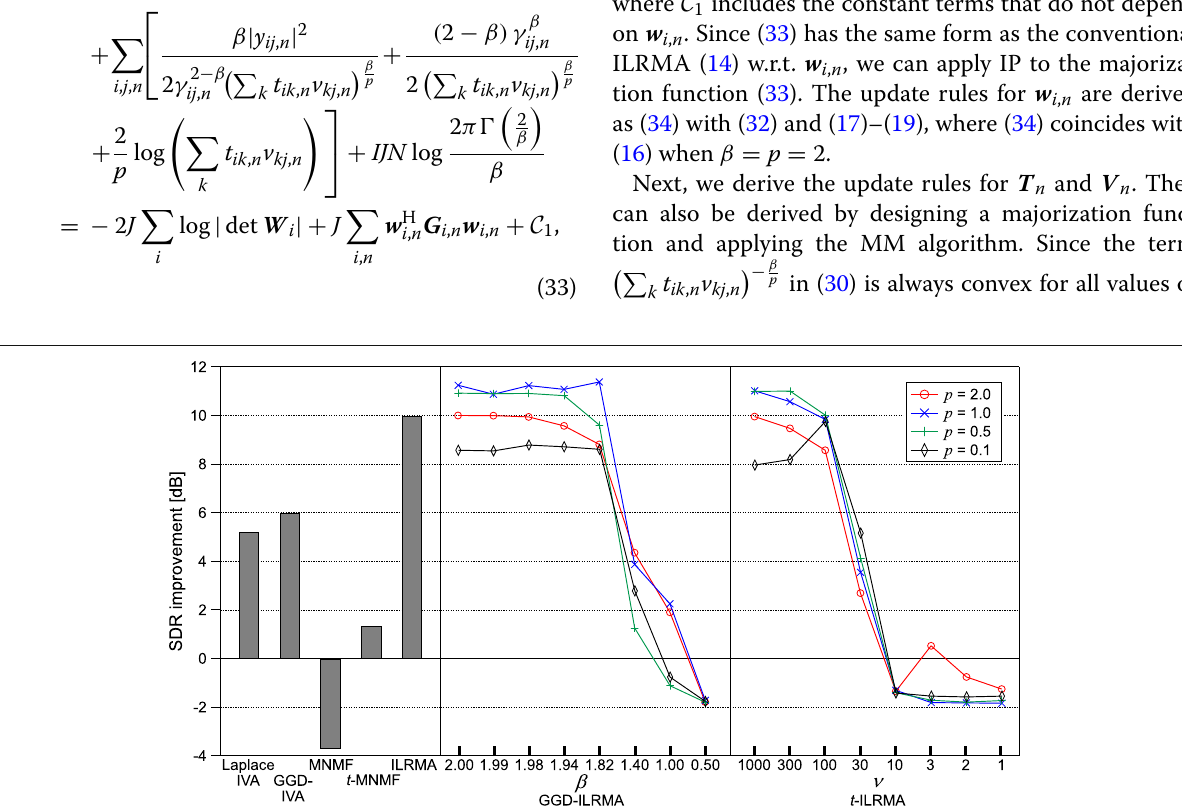
Fig. 10 Average SDR improvements of Speech 4 with E2A_1 signal using fixed parameters. The results for GGD-IVA and t -MNMF using β = 0.5 and ν = 1 are shown, which are their best parameter